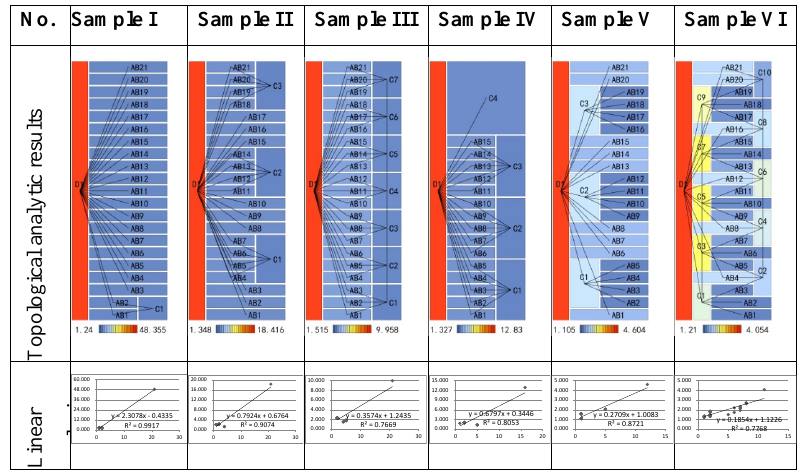
Table 4 Topological structure analysis